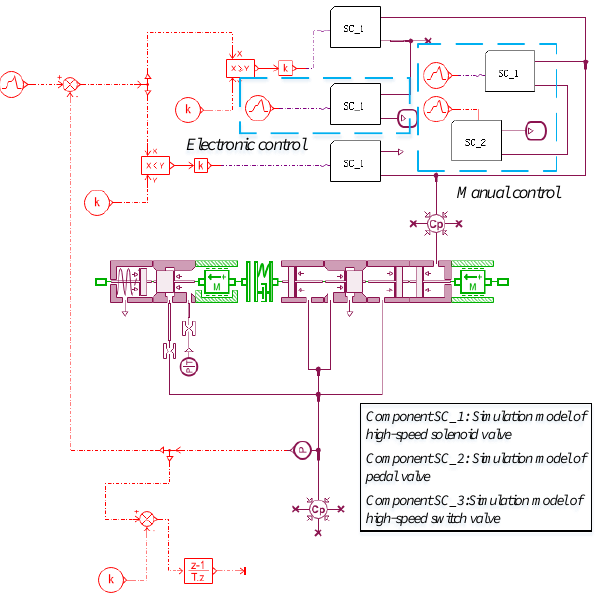
Figure 5. Simulation model for the pressure regulation characteristics of the APRV of the different structural configurations in the ECPBS of commercial vehicles.